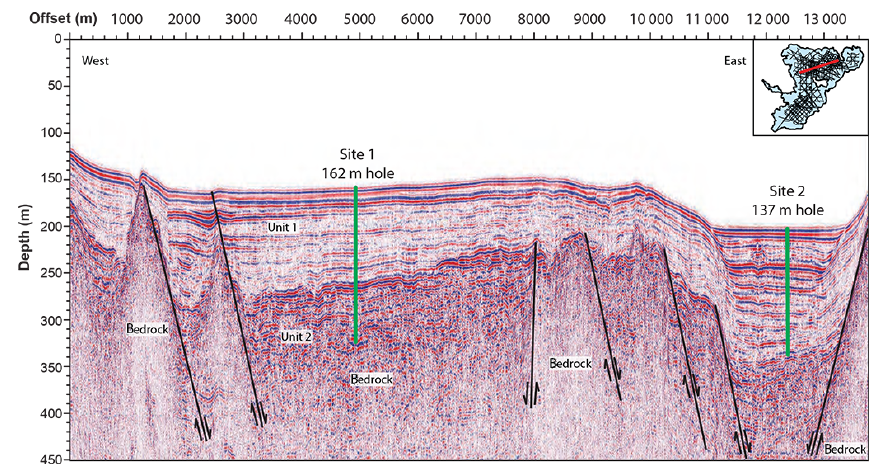
Figure 3. Seismic reflection profile oriented WSW–ENE over Lake Towuti’s northern basin (see inset for line position) crossing TDP Sites 1 and 2. Thick green lines show the borehole depths for TDP-TOW15-1B and TDP-TOW15-2A. Seismic Units 1, 2, and bedrock are labeled, and major faults are indicated by thin black